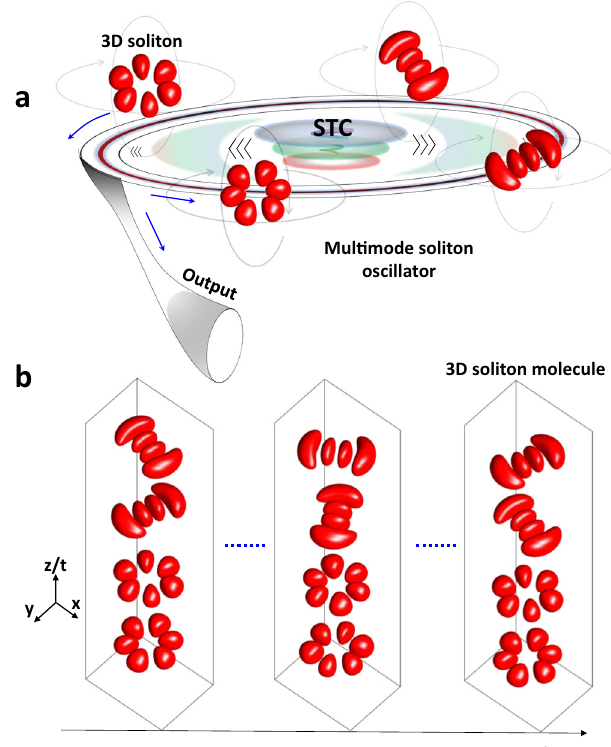
Fig. 1 | Formation of 3D soliton molecules in a multimode soliton oscillator. a Conceptional diagram of 3D soliton molecules generated in a multimode soliton oscillator.Multiple3Dopticalsolitonscanbegeneratedinaspatiotemporalmode- locked fi ber laser (numerical simulation is attached in Supplementary Note 1). The coexisted 3D optical solitons are bound together as 3D soliton molecules through spatiotemporalcoupling(STC).Thegenerated3Dsolitonmoleculestheninternally and externally evolve, giving rise to diverse spatial-temporal-spectral dynamics. b Simulated evolution of 3D soliton molecules over multiple roundtrips. The 3D isosurface plot is utilized for better